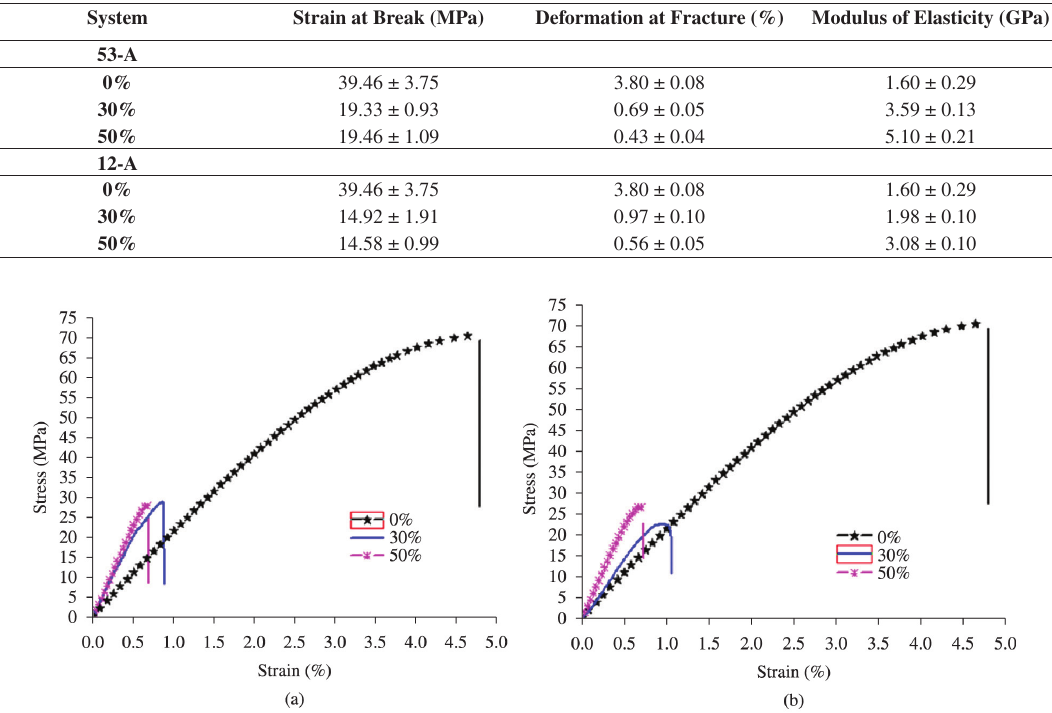
Table 5. Results of the mechanical tensile tests.